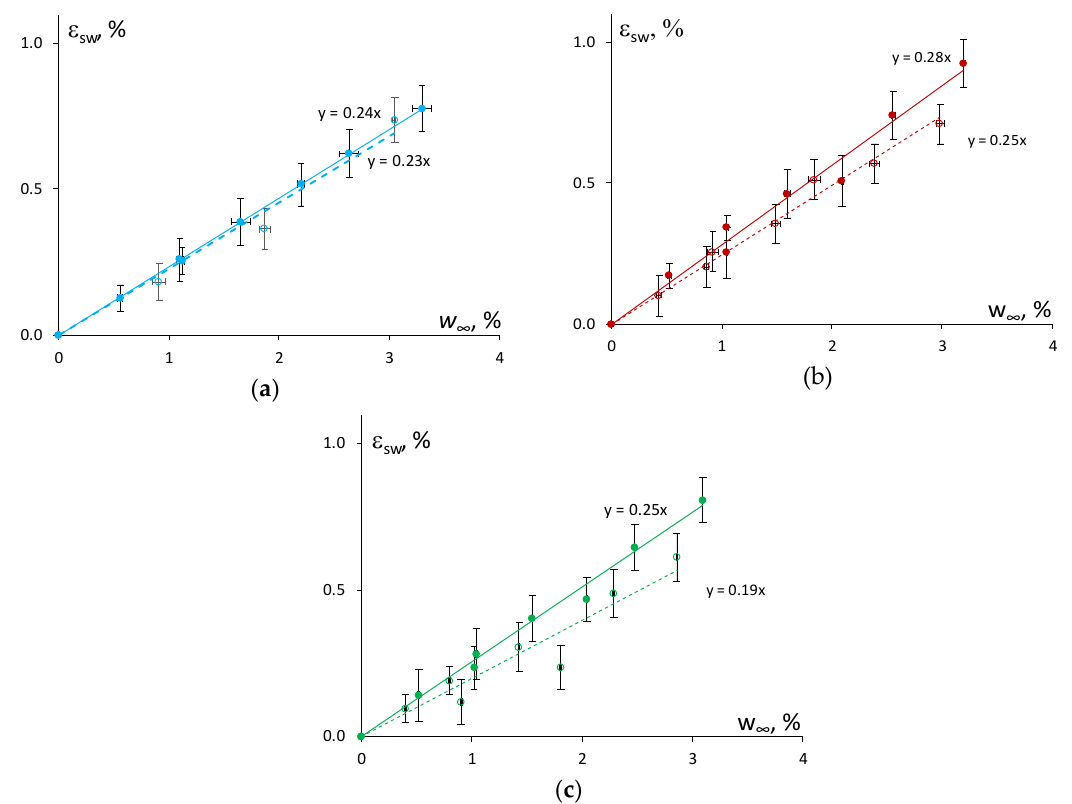
Figure 4. Swelling strain vs. moisture content for the absorption (solid line) and resorption (dashed line) of the epoxy ( a ) and the epoxy filled with 0.1 wt % of N ( b ) and 2 wt % of SA ( c ).